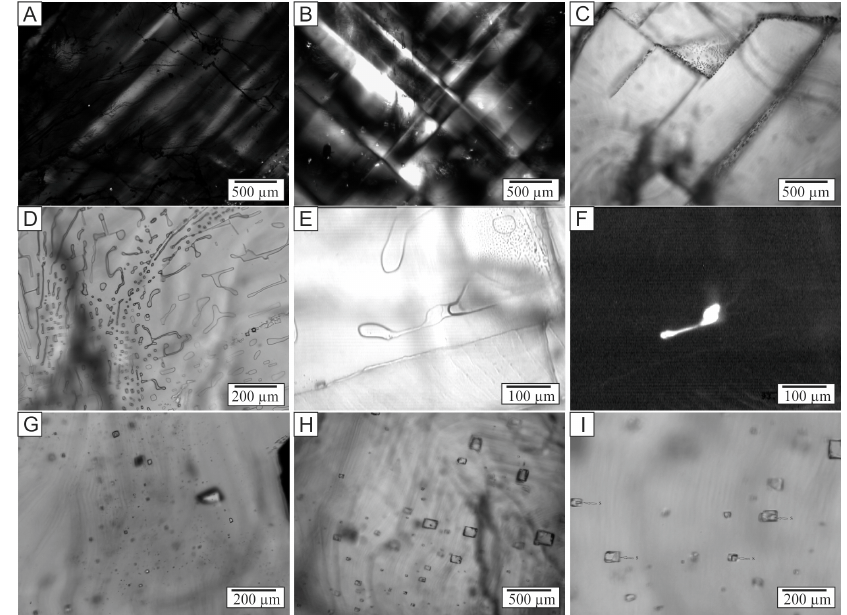
Figure 5. Microscopic images of halite crystals: ( A ) birefringent set of belts in halite crystal (depth − 1190.7 m a.s.l.). ( B ) Two birefringent sets of belts which intersect at a right angle (depth − 1187.6 m a.s.l.). ( C ) Small secondary or pseudosecondary fluid inclusion assemblages (FIAs) (depth − 1190.8 m a.s.l.). ( D ) Large secondary or pseudosecondary FIAs (depth − 1190.8 m a.s.l.). ( E , F ) Secondary flatten